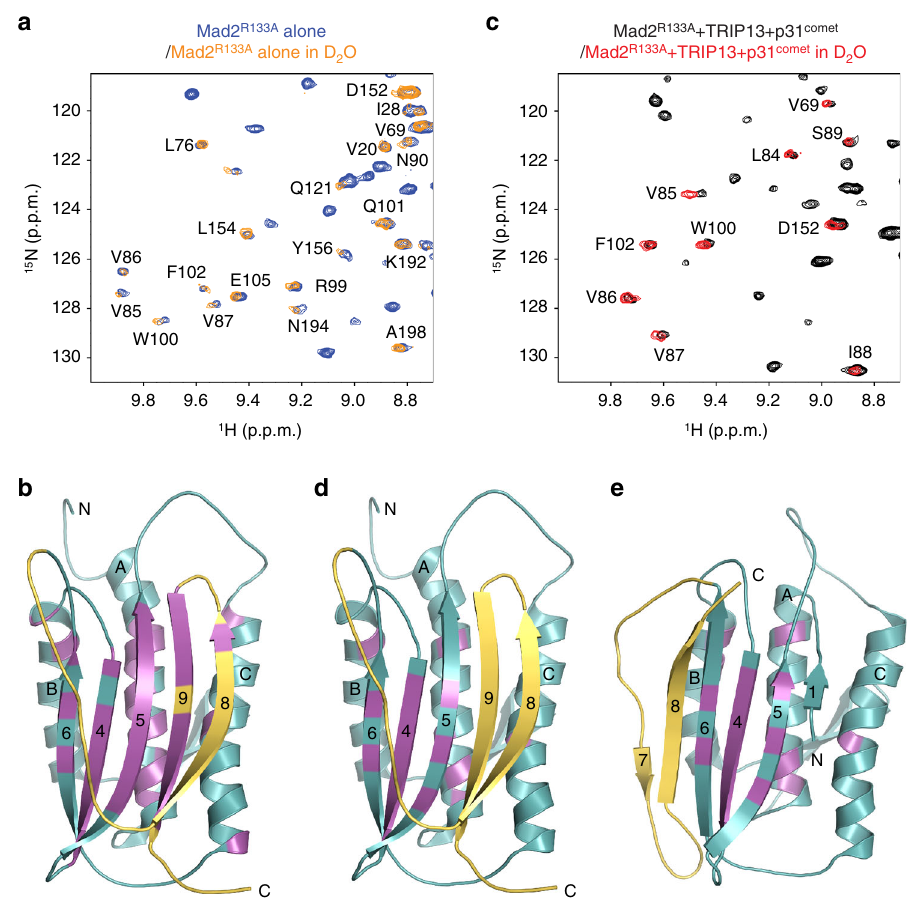
Fig. 2 TRIP13-catalyzed structural transition of Mad2 does not involve Mad2 global unfolding. a Overlay of regions of the 1 H – 15 N HSQC spectra of 15 N- labeled C-Mad2 R133A in H 2 O (blue) and C-Mad2 R133A in D 2 O (orange). Residues with slow-exchanging amides are labeled. b Ribbon diagram of unliganded C-Mad2, with slow-exchanging residues in the absence of TRIP13 colored magenta. Strands in the major β sheet are labeled with their numbers. The N- and C-termini are indicated. c Overlay of regions of the 1 H – 15 N HSQC spectra of 15 N-labeled Mad2 R133A in H 2 O (black) and D 2 O (red) after the addition of ATP and sub-stoichiometric amounts of TRIP13 and Δ N35-p31 comet . Residues with slow-exchanging amides are labeled. d Ribbon diagram of unliganded C- Mad2, with slow-exchanging residues in the presence of TRIP13 colored magenta. e Ribbon diagram of O-Mad2, with slow-exchanging residues in the presence of TRIP13 colored